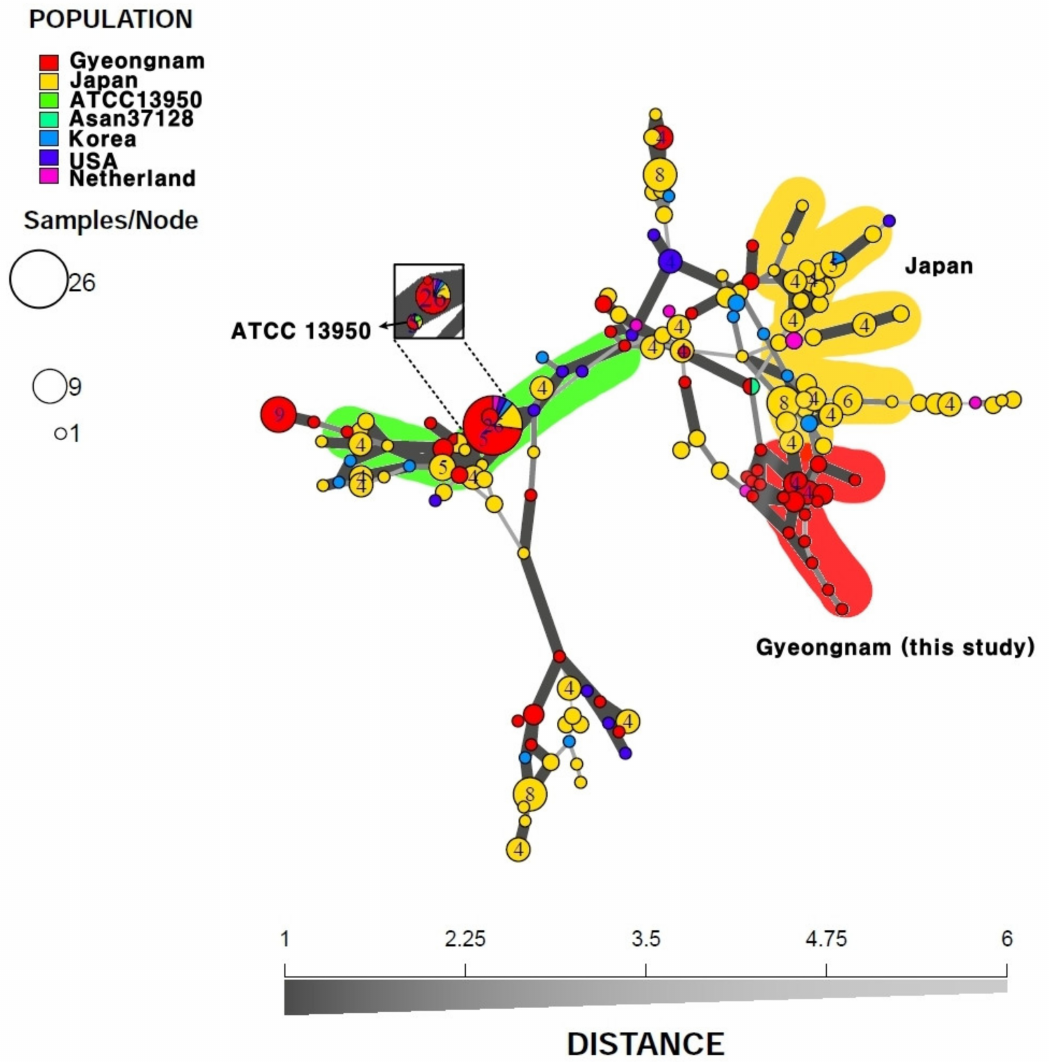
Figure 4. Minimum spanning tree of the variable number tandem repeat (VNTR) types for the 365 M. intracellulare strains. The minimum spanning tree was generated by R program using 15 VNTR loci, excluding VNTR 11 of previous studies and this study. Strains from Japan (n = 226), Korea (n = 16), the Netherlands (n = 7), the U.S. (n = 15), Gyeongnam (n = 101, this study), and reference strains (ATCC 13950, Asan 37128) were analyzed and their genetic distance was